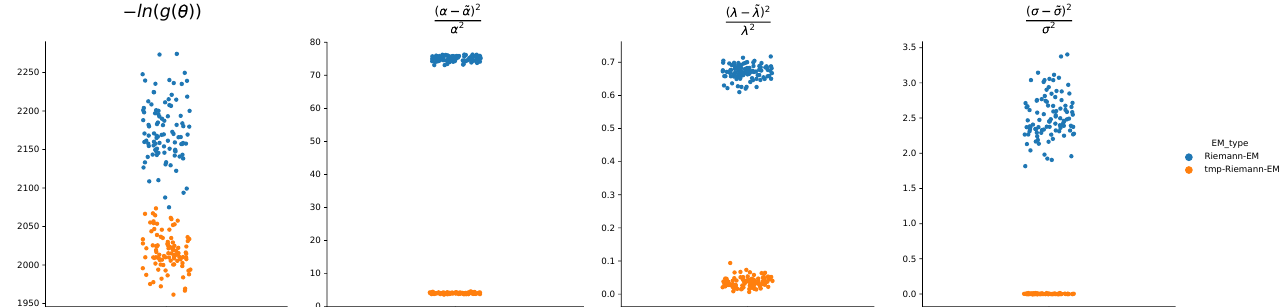
Figure 7. Results over many simulations of the Riemann EM and tmp-Riemann EM on the Beta- Gaussian model. The tempered Riemann EM reaches relative errors on the real parameters that are orders of magnitude below the Riemann EM with no temperature. The likelihood reached is also lower with the